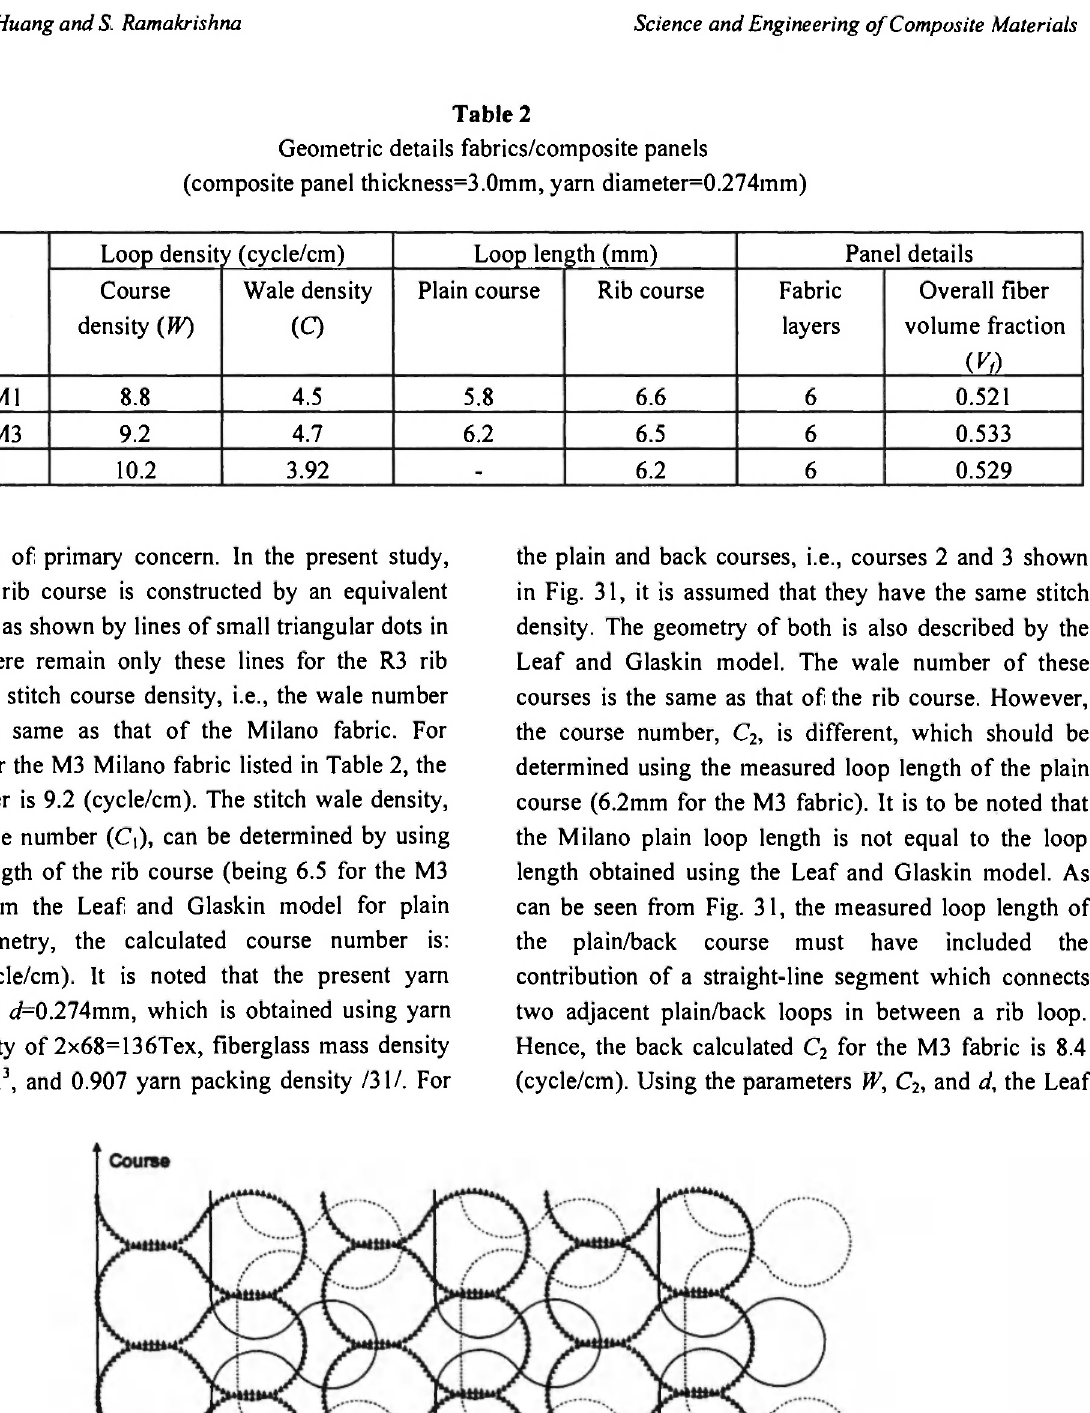
Geometric details fabrics/composite panels